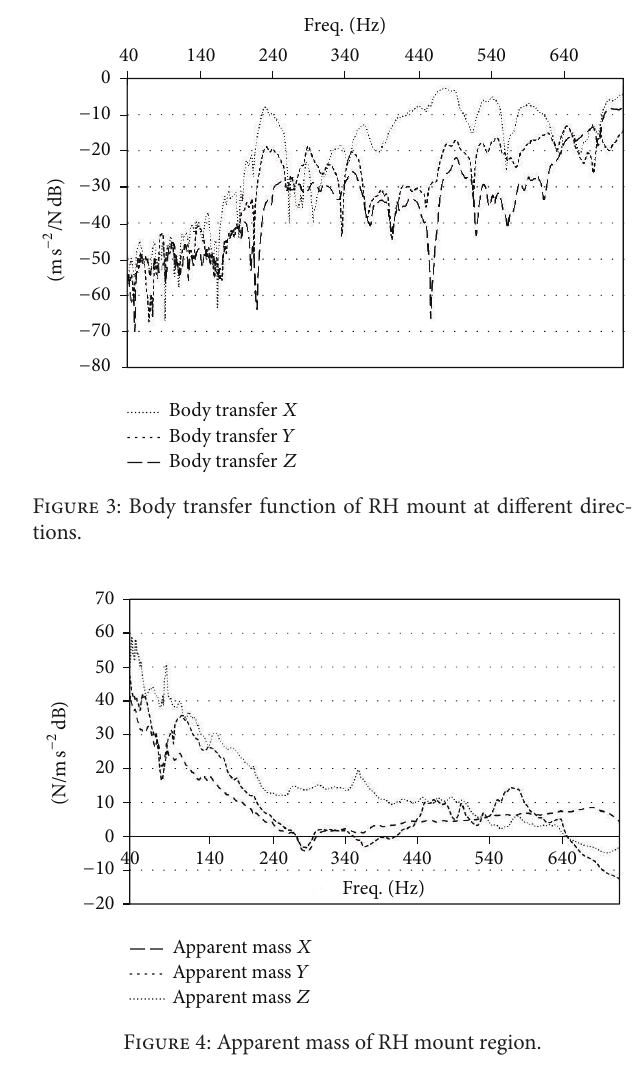
(𝑓)/𝑎 (𝑓) an body body